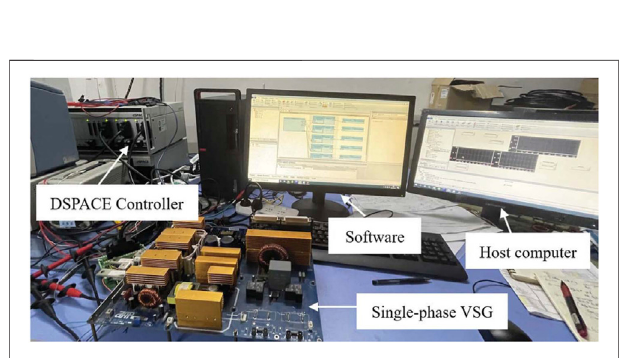
FIGURE 12 | Experimental